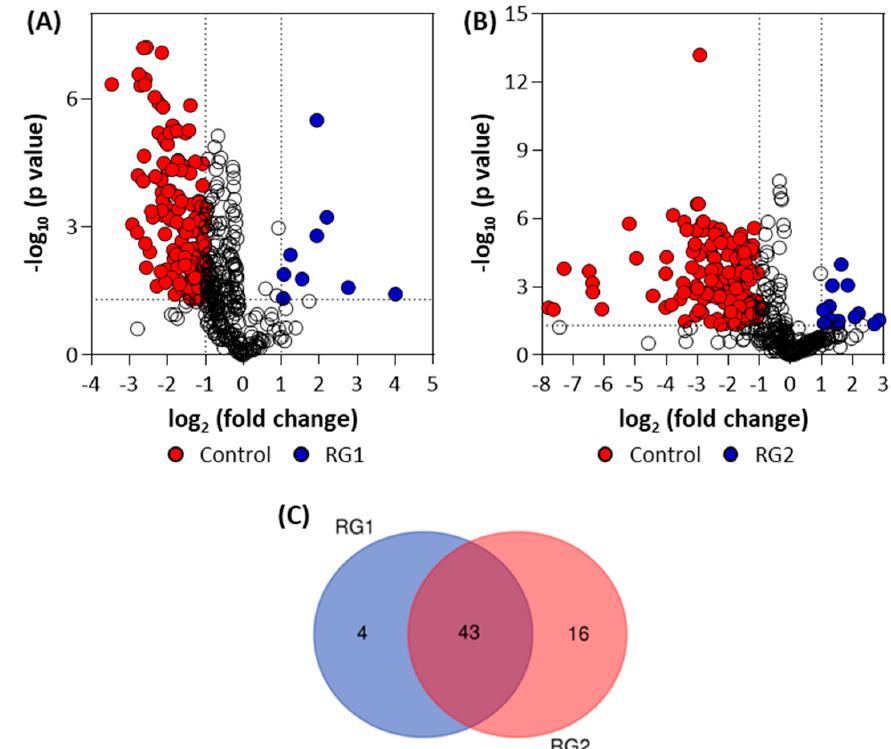
Figure 9. Volcano plots for bacterial pellet samples collected from ( A ) RG1-inoculated and ( B ) RG2-inoculated spinach samples (note, the negative group includes Salmonella ) and ( C ) Venn diagram showing the statistically significant and identified “unique” metabolites. Note: The colored circles in panels A and B represent each detected significant metabolite. The open black circles represent non-significant ( p -value > 0.05) metabolites.